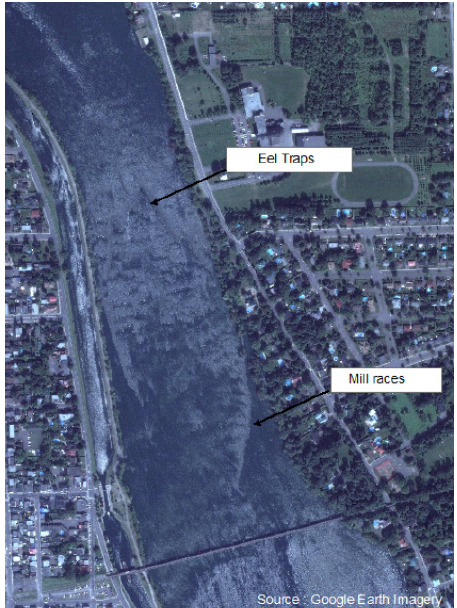
Figure 9. Submerged structures in the Saint-Jean-sur-Richelieu shoal area.